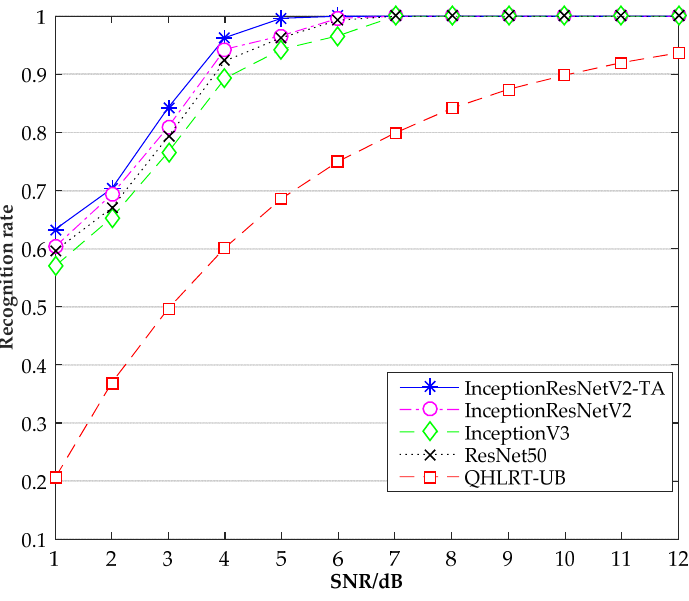
Figure 8. Recognition rate comparison of 8PSK by different methods.